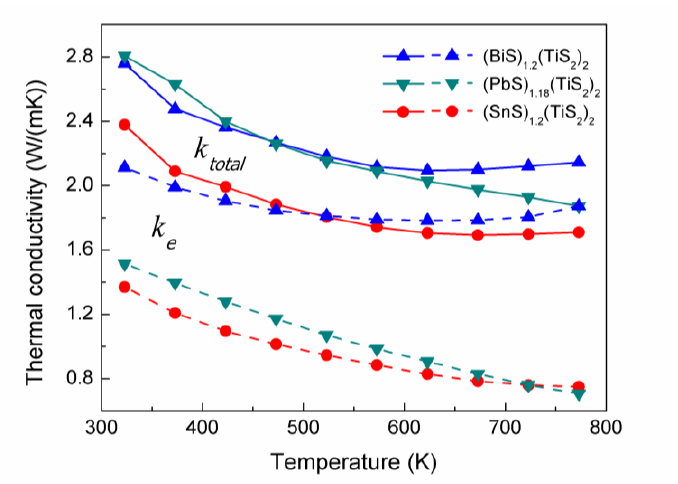
and (PbS) (TiS ) , (SnS) (TiS ) 1.2 2 2 1.2 2 2